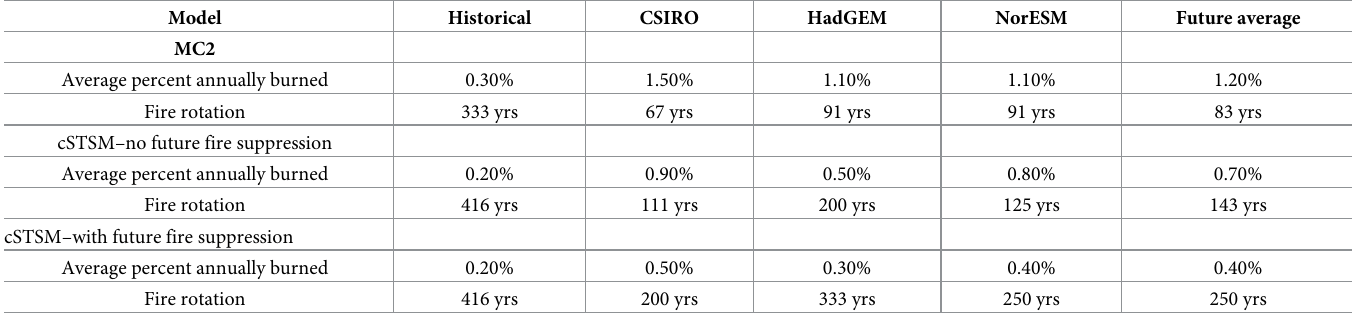
Table 2. Average annual percent area burned and fire rotation projected by each model under different climate scenarios.